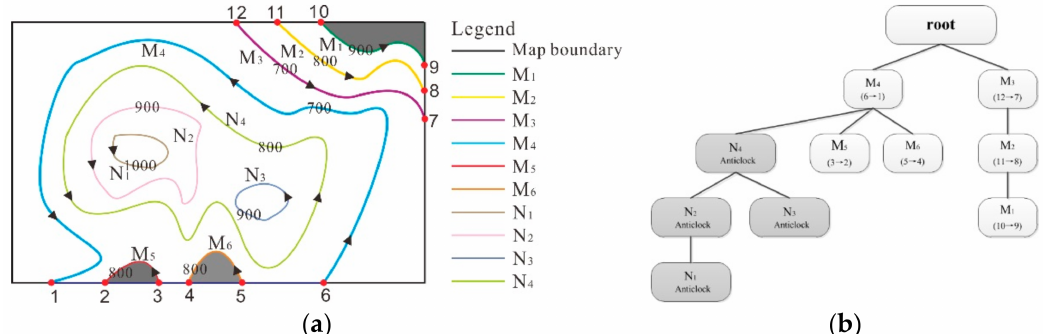
Figure 6. Automatic direction adjustment of contour direction: ( a ) contour lines labeled with elevation and direction and ( b ) “directed adjacent relation tree” (DART).